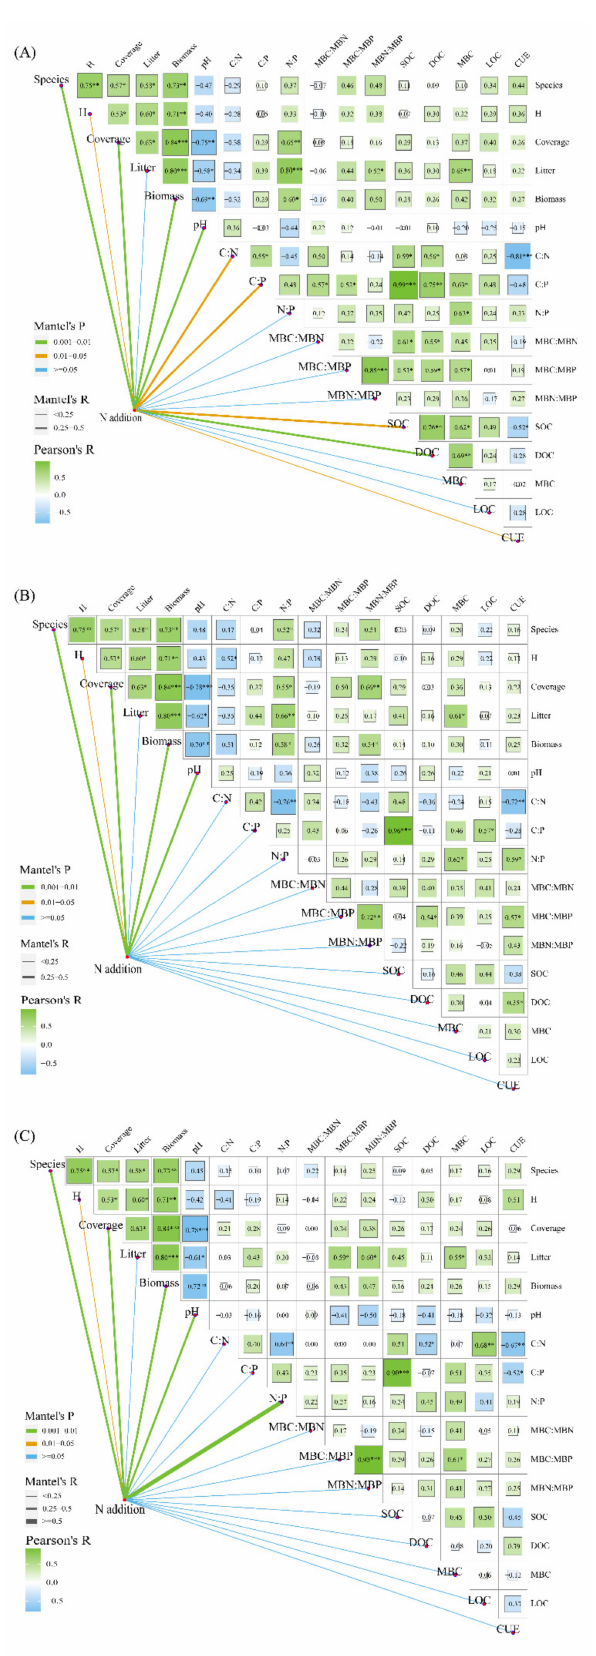
Figure 3. The drivers of soil microbial CUE in macro-aggregates ( A ), medium aggregates ( B ), and micro-aggregates ( C ). The pairwise correlation heat map of environmental factor indicators and